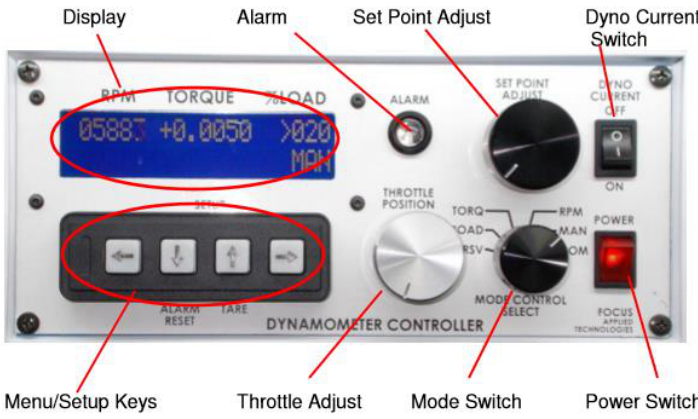
Figure 9. ( a ) Experimental set-up of the CAWT; and ( b ) detailed dimensions of a building integrated with a CAWT and dimensions of the ventilation fans (all dimensions in mm).